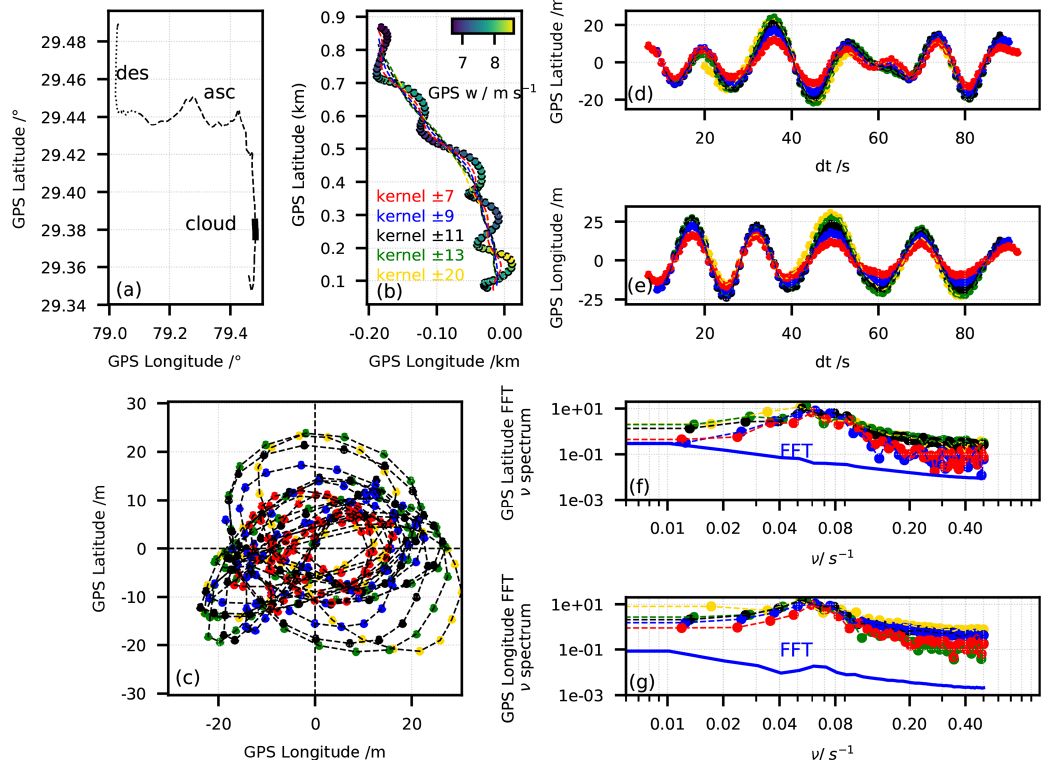
Figure A1. Fast Fourier transform (FFT) analysis for the determination of the pendulum oscillation period applied to mixed-phase cloud of flight NT011. (a) Payload trajectory: ascent (dashed), descent (dotted) and mixed-phase cloud between 9.25 and 10km altitude (thick black line). (b) Zoom-in of the mixed-phase cloud: payload trajectory (ascent velocity coloured dots) and balloon trajectories (dashed lines). The different lines have been smoothed from the payload trajectory with moving average intervals; yellow: ± 20s; green: ± 13s; black: ± 11s; blue: ± 9s; red: ± 7s. (c) Detrended payload oscillations. (d) Time series of the latitude values used in panel (c) . (e) Time series of the longitude values used in panel (c) . (f) Power spectral density of the latitude time series after FFT analysis. (g) Power spectral density of the longitude time series after FFT